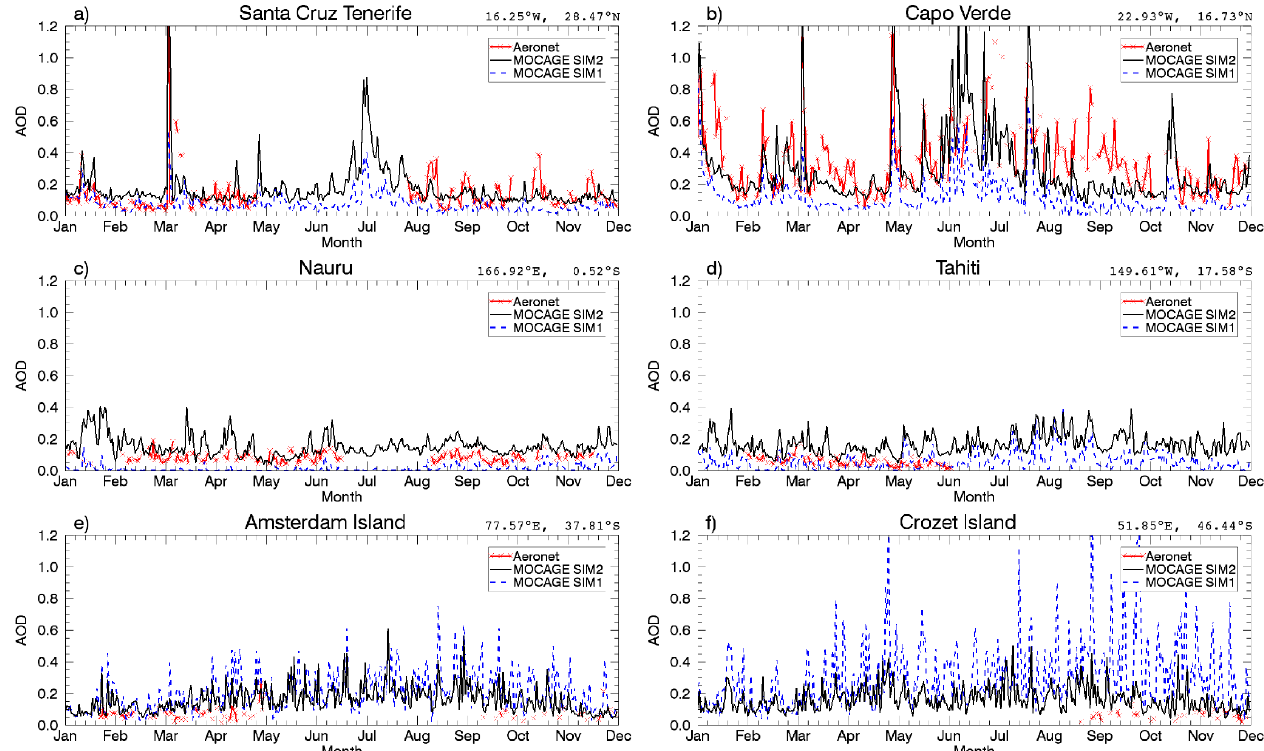
Figure 7. Time series of aerosol optical depth at 550nm from the AERONET data, SIM1 and SIM2 for six AERONET stations: Tenerife Santa Cruz (16.25 ◦ W, 28.47 ◦ N), Cabo Verde (22.93 ◦ W, 16.73 ◦ N), Nauru (166.92 ◦ W, 0.52 ◦ S), Tahiti (149.61 ◦ W, 17.58 ◦ S), Amsterdam Island (77.57 ◦ E, 37.81 ◦ S) and Crozet Island (51.85 ◦ E, 46.44 ◦ S). Correlation, modified normalized mean bias and fractional gross error for both SIM1 and SIM2 compared to AERONET observations are given in Table 3. The descriptions of the model simulations are in Table 2.